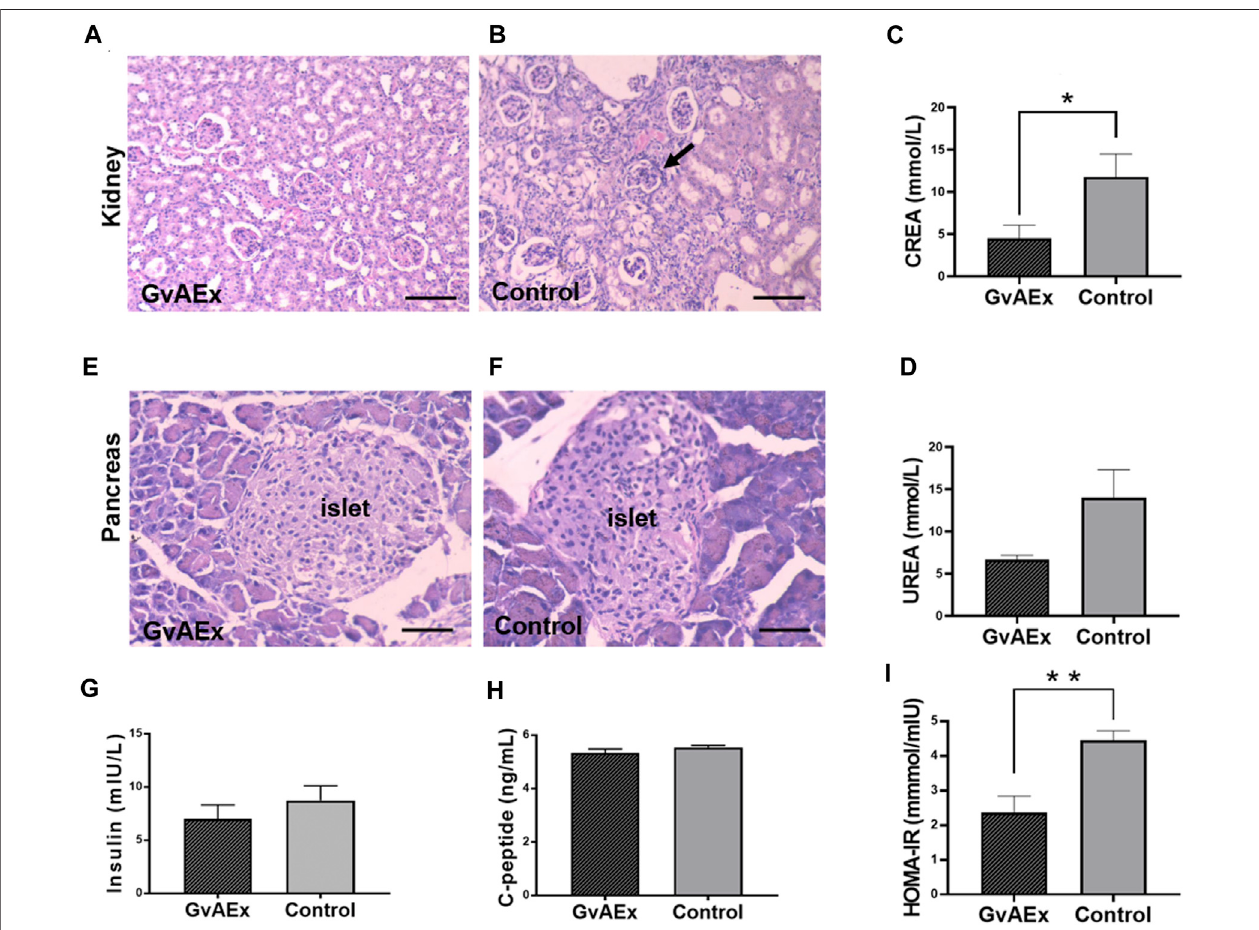
FIGURE 2 | Treatment of GvAEx improves kidney and islet function in diabetic mice. (A,B) Representative light microscopic images of kidney after 12 weeks of GvAEx (A) or vehicle (B) treatment (scale bar = 100 μ m). (C,D) Plasma levels of Creatinine (CREA) (C) and urea (D) in the db/db mice treated with GvAEx or vehicle for 12 weeks ( n = 6/group). (E,F) Representative light microscopic images of pancreatic islet in GvAEx (E) and control mice (F) (scale bar = 50 μ m). (G,H) Serum levels of insulin (G) and c-peptide (H) ( n = 6/group). (I) HOMA-IR index of GvAEx and control mice ( n = 6/group). * p < 0.05, ** p < 0.01, *** p < 0.001.